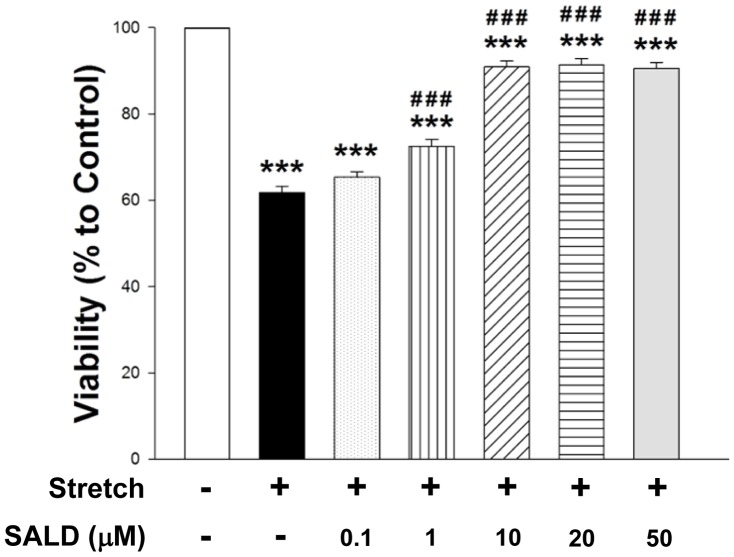
Protective effects of salidroside on stretch-induced cytotoxicity in primary cultured neurons.Treatment with salidroside at different concentrations (0.1, 1, 10, 20, and 50 µM) ameliorated stretch-induced cell viability loss in a dose-dependent manner. Values are presented as mean ± SEM of 3 independent experiments (n = 3); ***P<0.001 versus control, ###
P<0.001 versus stretch injury alone. All data were representative of 4 independent experiments.